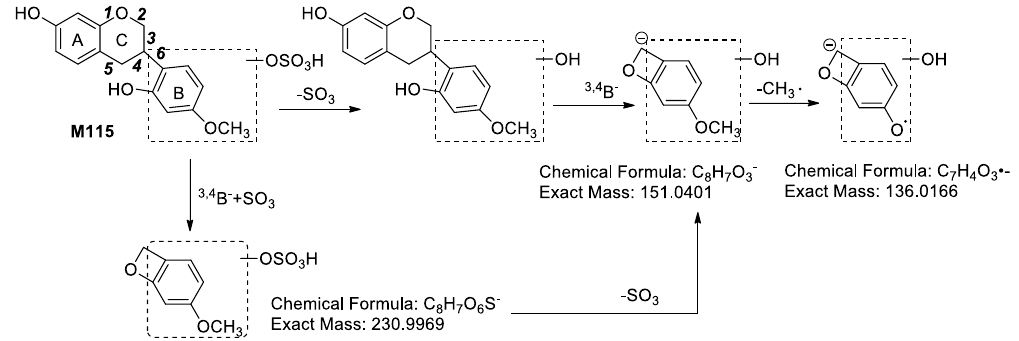
Figure 11. The probable structure and characteristic fragment ions of M115 .